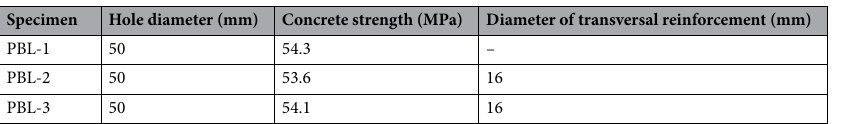
Table 1. Parameters of PBL shear connector specimens.